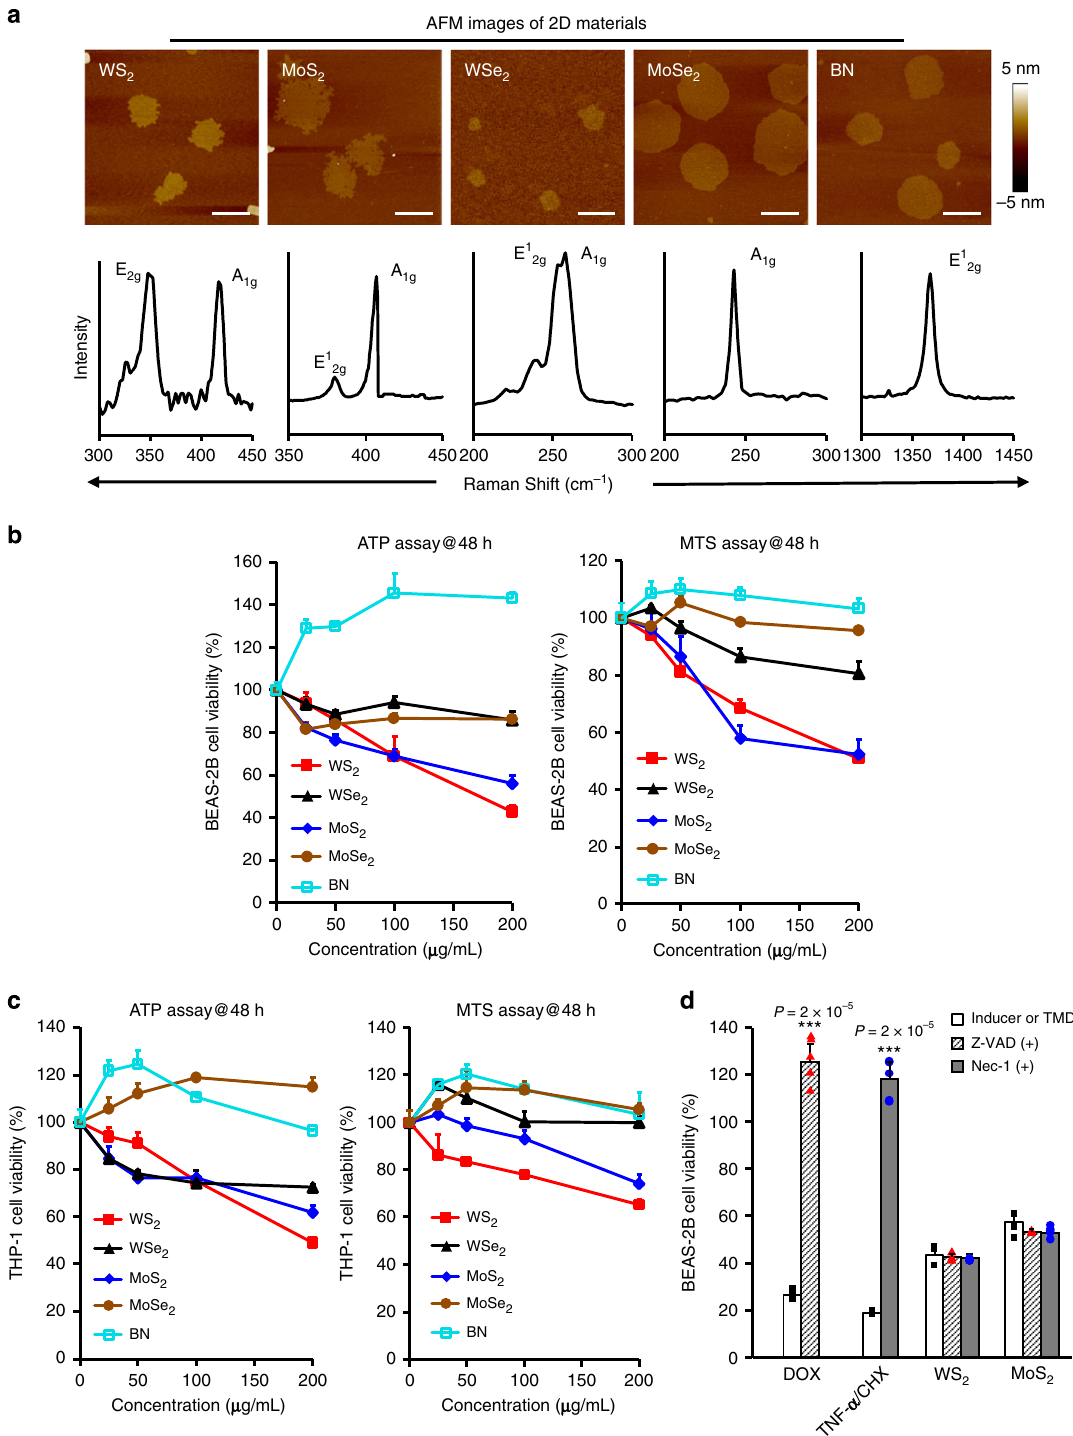
Fig. 1 Characterization of 2D TMDs and their cytotoxicity assessments. a Representative AFM images and Raman spectra of 2D TMDs. A drop of 2D TMDs suspension (50 μ g/mL) was placed on a mica plate, and then dried in vacuum drying oven for AFM observation (scale bar, 100 nm). 2D TMDs stock solutions (5 mg/mL) were freeze-dried to form powder for Raman spectra detection. Shown are the representative images from three independent experiments. Cell viability test in b BEAS-2B and c THP-1 cells. BEAS-2B and THP-1 cells were exposed to 2D TMDs at 0 – 200 μ g/mL for 48 h. The cell viability was examined by detecting luminescence and absorbance of substrates in ATP and MTS assays ( n = 3 biologically independent cell samples). Data are presented as mean values ± SD. d Effects of apoptosis and necrosis inhibitors on MoS 2 and WS 2 induced cytotoxicity. BEAS-2B cells pretreated with 50 μ M Nec-1, 20 μ M Z-VAD-FMK for 1 h were exposed to 2 μ g/mL DOX, formula of 100 ng/mL TNF- α and 1 μ g/mL CHX, 200 μ g/mL WS 2 and MoS 2 for 48 h to determine cell viability by ATP assay ( n = 3 biologically independent cell samples). Data are presented as mean values ± SD. *** p < 0.001 compared to inducer or TMD treatments by two-tailored Student t